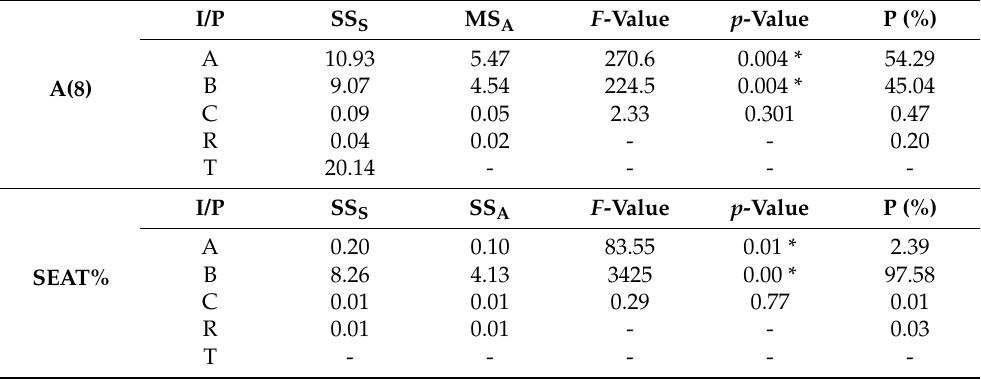
Table 3. Analysis of Variance for A(8) and SEAT% (Note: I/P: input parameters; A: average speed;